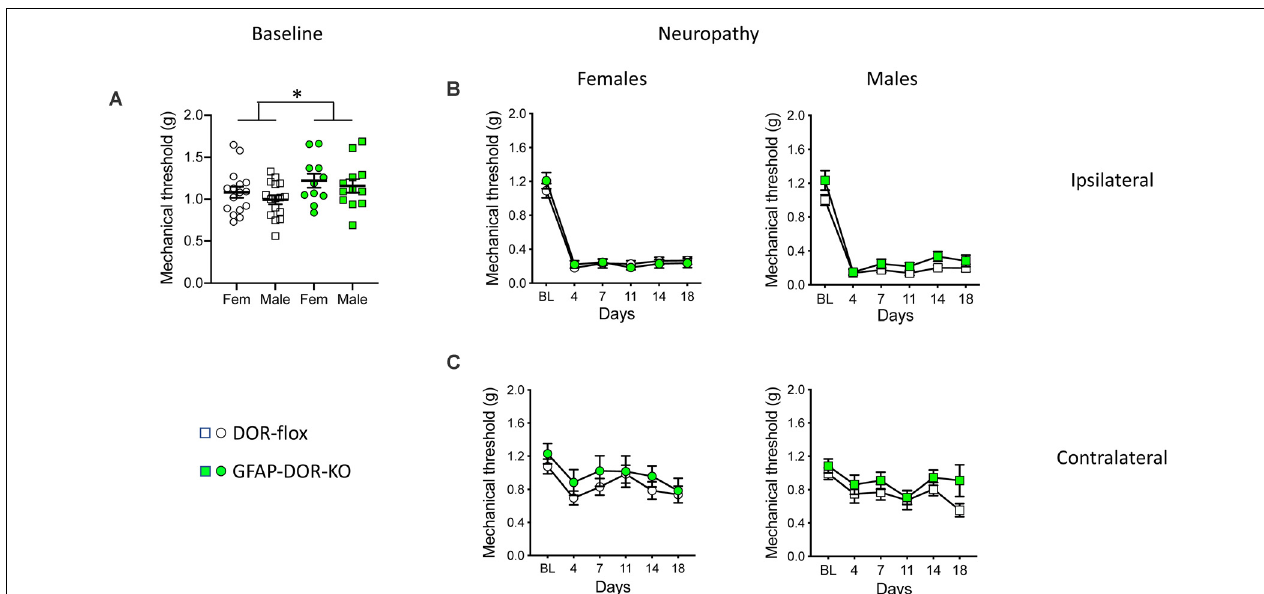
FIGURE 2 | Mechanical neuropathic allodynia in GFAP-DOR-KO mice. (A) Mechanical sensitivity thresholds in GFAP-DOR-KO and DOR-flox mice. GFAP-DOR-KO mice showed overall higher nociceptive mechanical thresholds. There was no genotype difference when evaluated in separated sexes (Two-way ANOVA followed by Sidak’s multiple comparison tests). ∗ , p < 0.05 GFAP-DOR-KO vs. DOR-flox. (B) Partial sciatic nerve ligation (pSNL) induced comparable mechanical allodynia at the ipsilateral side in GFAP-DOR-KO and DOR-flox mice of both sexes. (C) pSNL induced a mild allodynia at the contralateral side in both GFAP-DOR-KO and DOR-flox mice in the two sexes. n = 16 DOR-flox females, n = 11 GFAP-DOR-KO females, n = 16 DOR-flox males, n = 12 GFAP-DOR-KO males. Two-way repeated measures ANOVA followed by Sidak’s multiple comparison test. Data are expressed as mean ± SEM. See also Supplementary Table 2 for